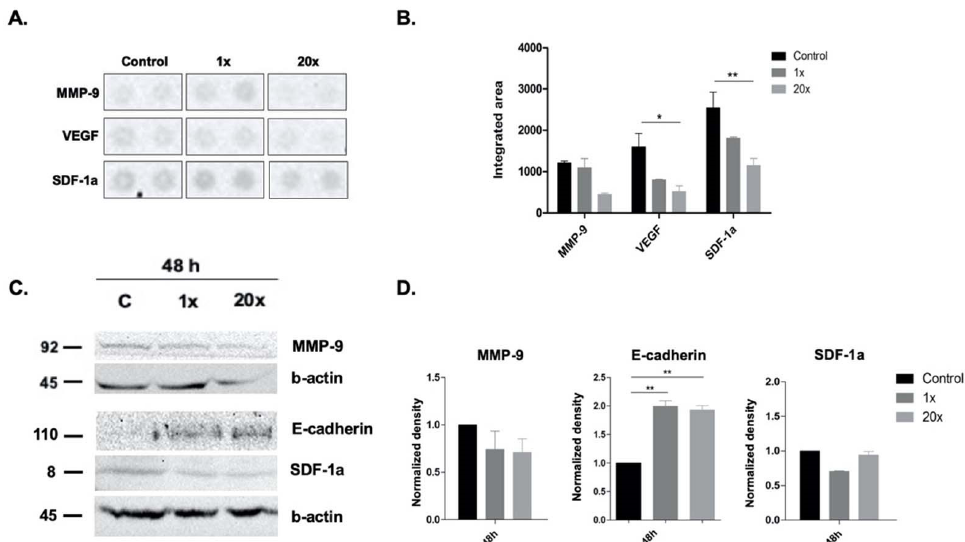
Figure 4. Cytokine array and Western blot analysis of metastatic potential-related markers in Panc- 1 cell line. Significantly decreased VEGF and SDF-1a level by cytokine array and SDF-1a level by Western blot were detected in Panc-1 cells after 48 h of 20× methyl-donor treatment ( A – D ). Expect- edly, E-cadherin level changed inversely, and its significant increase was detected after 48 h of 20× methyl-donor treatment ( C , D ). Unexpectedly, we could not measure significantly decreased MMP- 9 level after the methyl-donor treatments. Each bar represents the average normalized density from at least 3 repeats ± SD. Statistical significance are plotted as *: p < 0.05; **: p < 0.01. 1× and 20×: con- centrations of methyl donors.